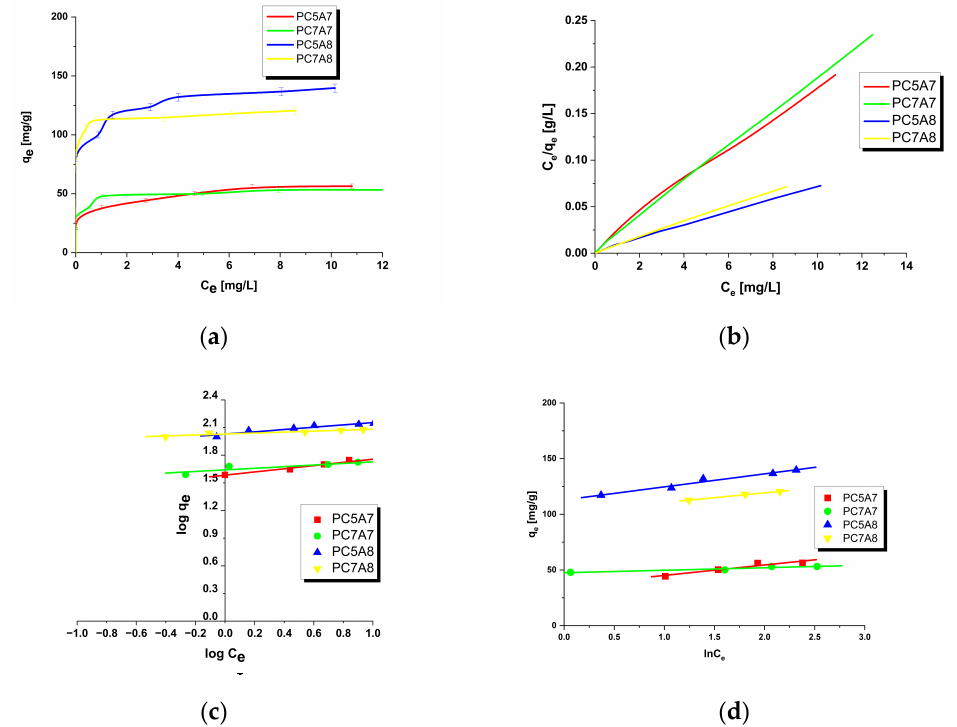
Figure 2. Adsorption of methylene blue onto activated carbons ( a ) equilibrium adsorption of the dye, ( b ) Langmuir isotherm plots, ( c ) Freundlich isotherm plots and ( d ) Temkin isotherm plots.